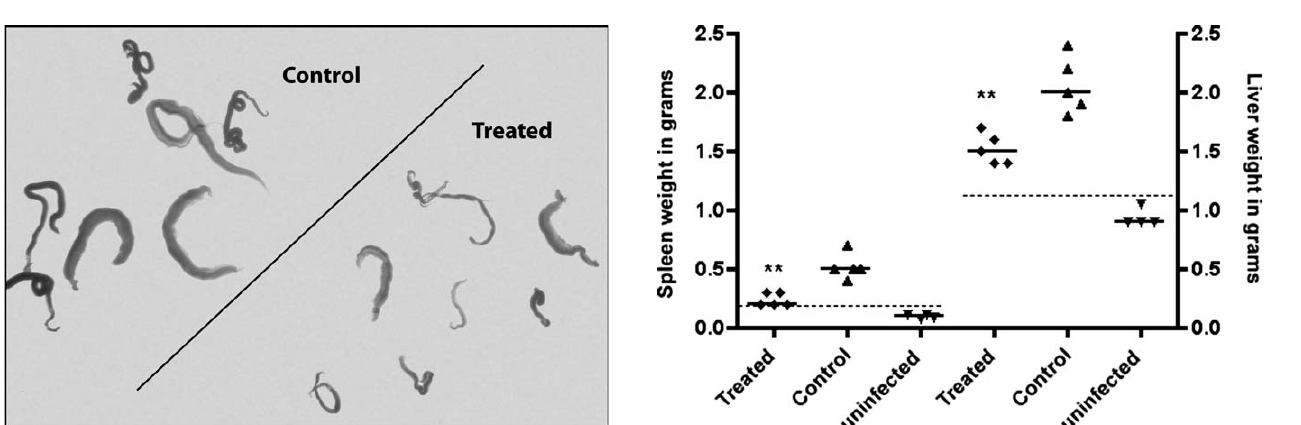
Figure 4. Long-Course Treatment with K11777 Resolves Egg-Induced Hepato- and Splenomegalies in S. mansoni –Infected Mice Points represent data from individual mice that were infected and treated, infected and untreated (control), or uninfected (Figure 1). The horizontal bars represent median values: ** p ¼ 0.007 . The hatched lines represent the baseline for age-matched uninfected mice.